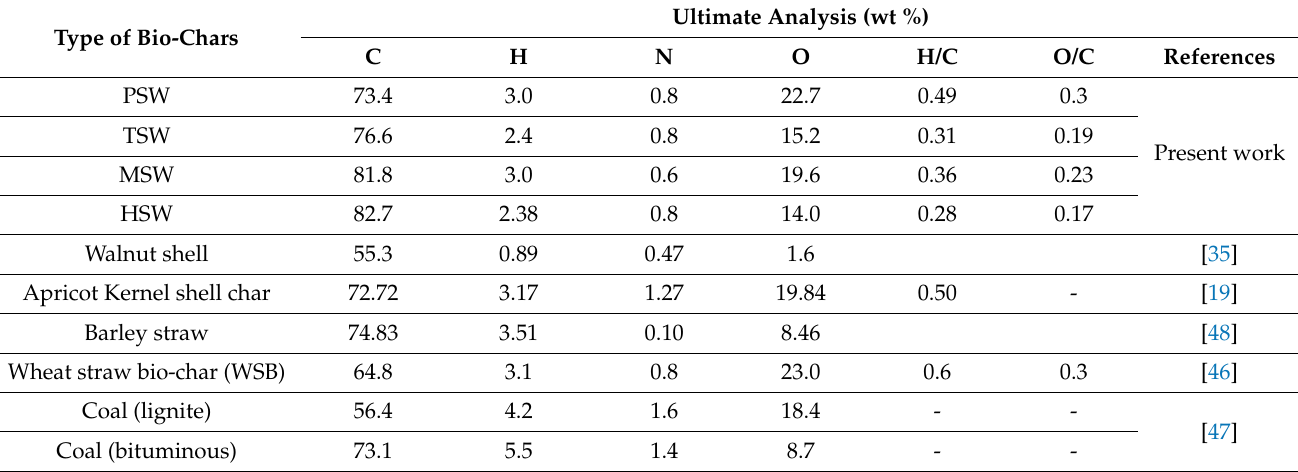
Table 2. Elemental analysis and H/C and O/C values of bio-chars obtained at particle size